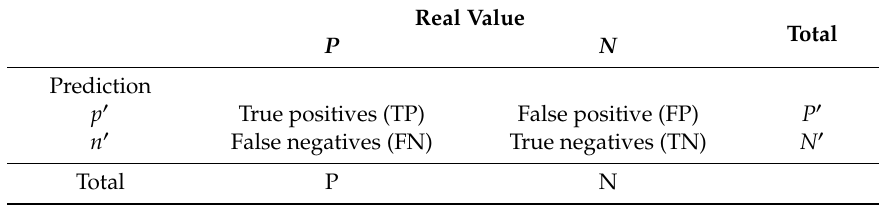
Table 6. Confusion matrix for the receiver operating characteristic (ROC) analysis.